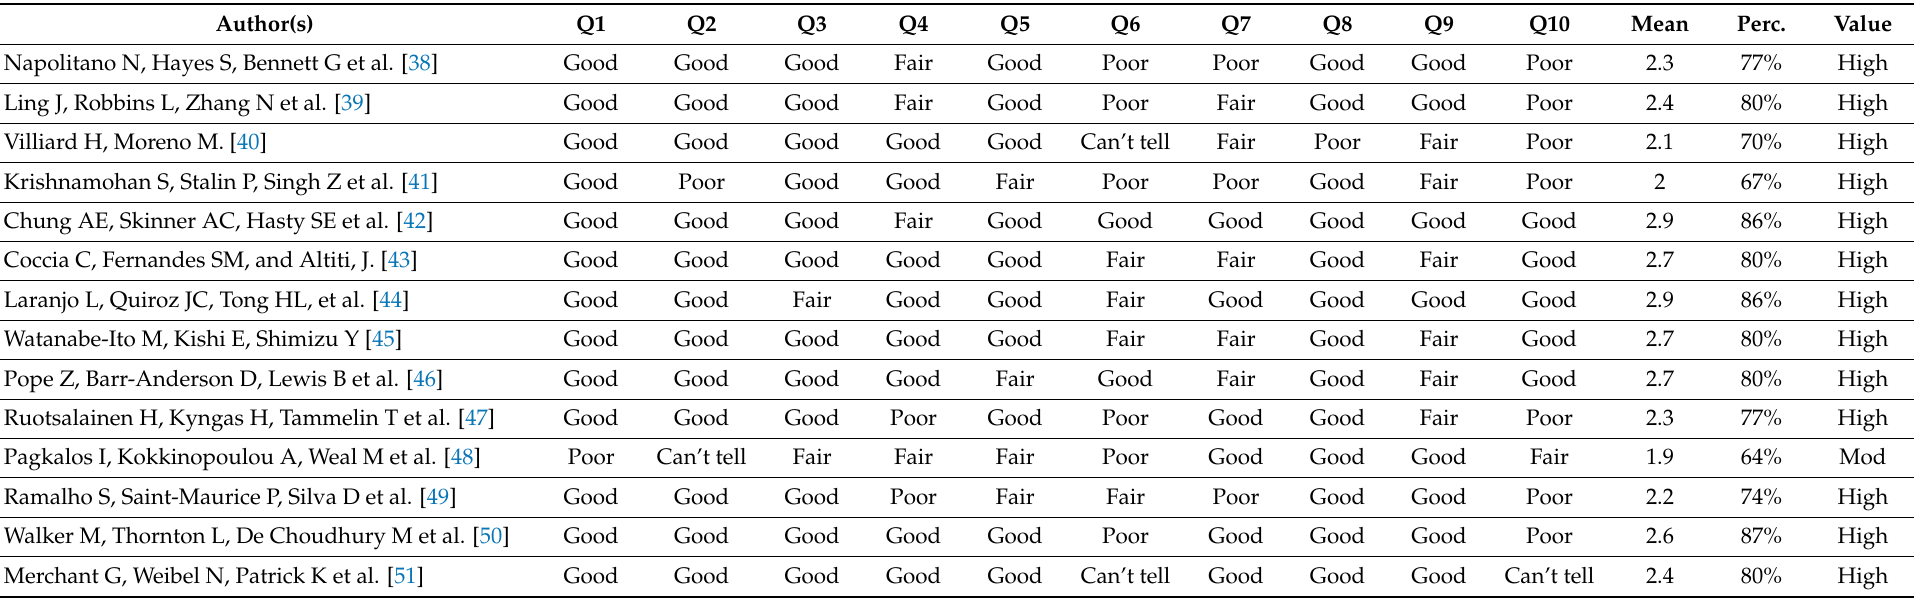
Table A1. Scoring system for the methodological quality of the included